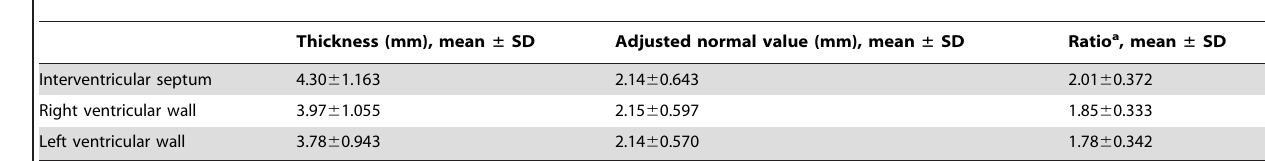
Table 1. Cardiac dimensions in fetuses with urinary tract malformations (n =37) and gestational age-adjusted normal values.